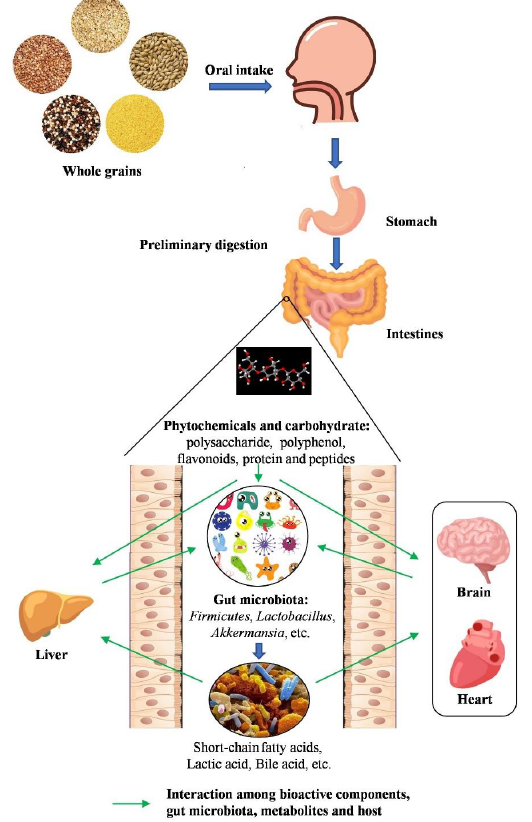
Figure 1. The interaction between whole grains and gut microbiota. The bioactive components of whole grains, which are produced after oral, gastric, and small intestine digestion, improve gut health by modulating gut microbiota. Phytochemicals and carbohydrates are metabolized by gut microbiota into short-chain fatty acids (SCFAs) and other small functional molecules. These func- tional components can regulate gut microbiota that contribute to exerting health effects on various diseases.